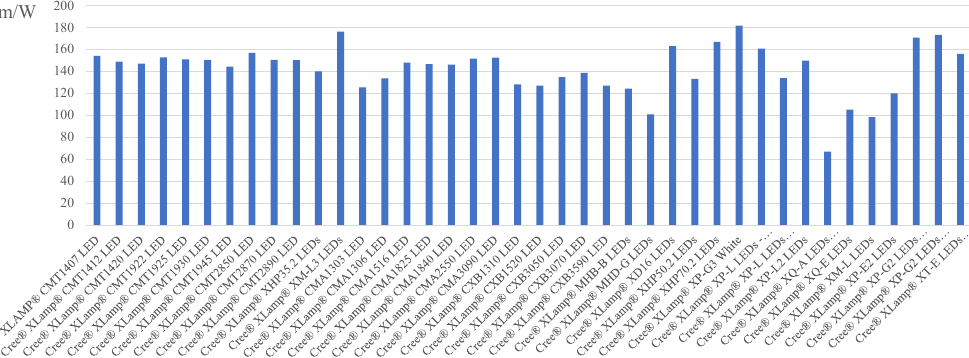
Figure 2. Cree LED manufacturer different LED chip comparison in terms of efficiency (Lm/W), date obtained at the end of 2020